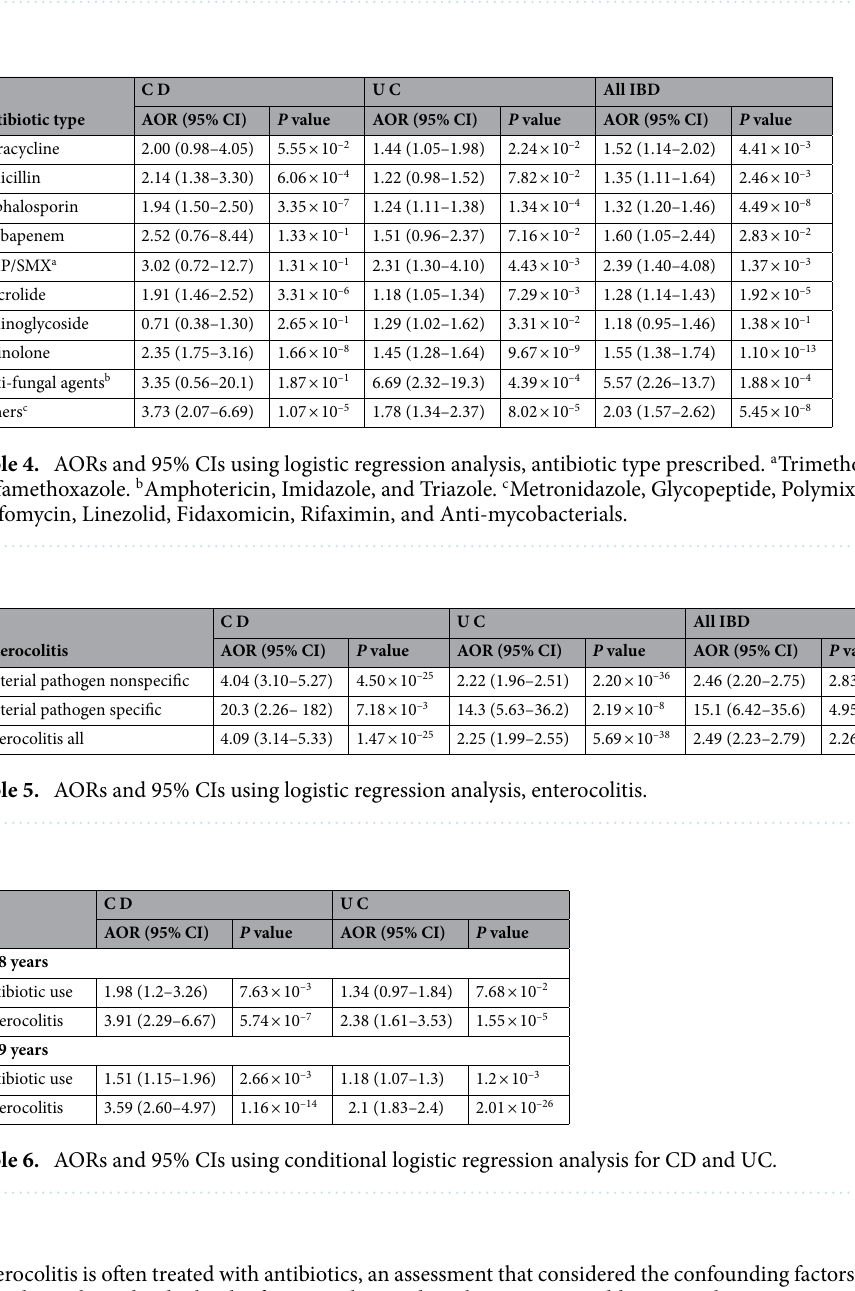
Table 3. AORs and 95% CIs using logistic regression analysis, number of antibiotic types prescribed. a Three or more. b Incorporate 1, 2, and 3 +.